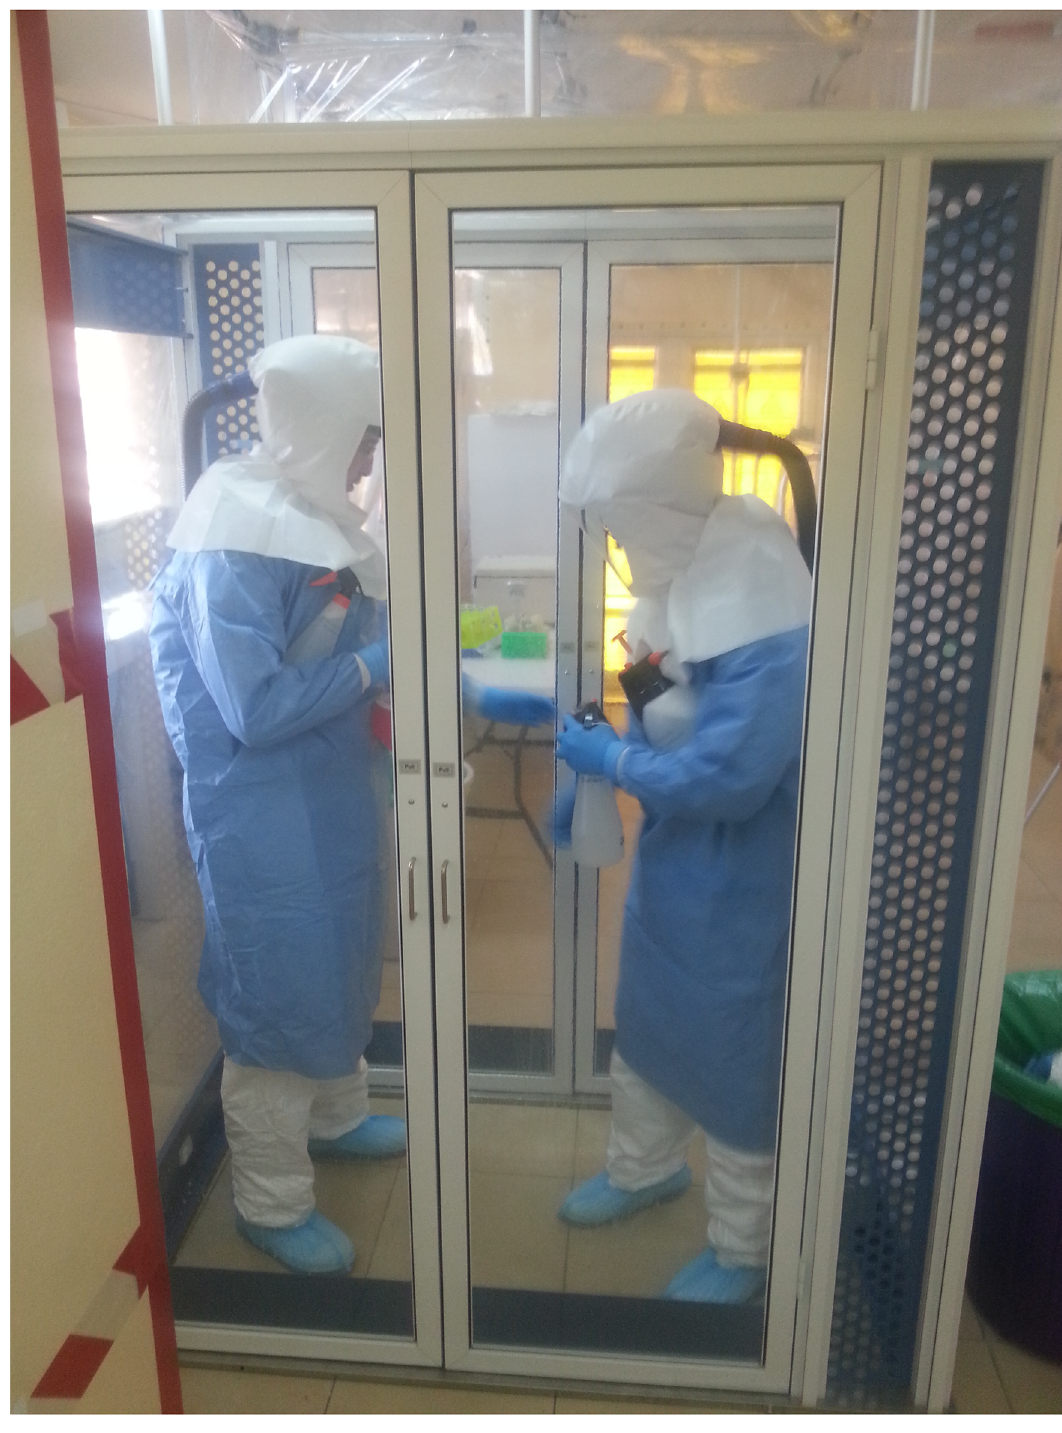
Fig 2. Operators dressed in BSL3 PPE (scrubs, Tyvek suits, surgical gown, double pair surgical gloves, gumboots, overshoes and PAPR with full face hood) entering the IsoArk main chamber through the airlock.